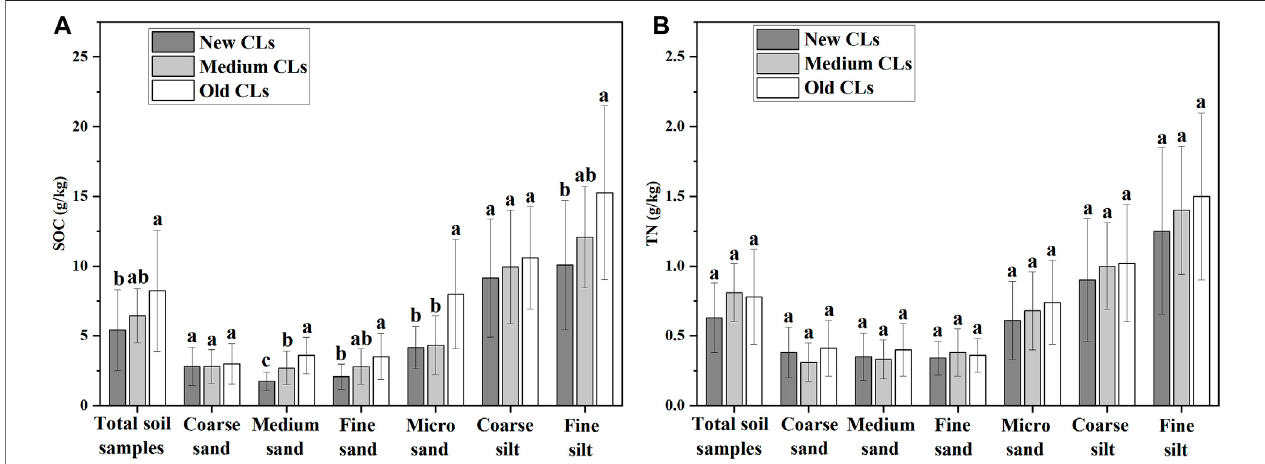
FIGURE5|(A) SOCcontentinthedifferentparticlesizegroupsinthenew,mediumandoldCLs,and (B) TNcontentinthedifferentparticlesizegroupsinthenew, medium and old CLs. The lowercase letters denote the differences in the SOC and TN contents among the CLs of the different cultivation years based on one-way analysis of variance followed by LSD tests ( p < 0.05).